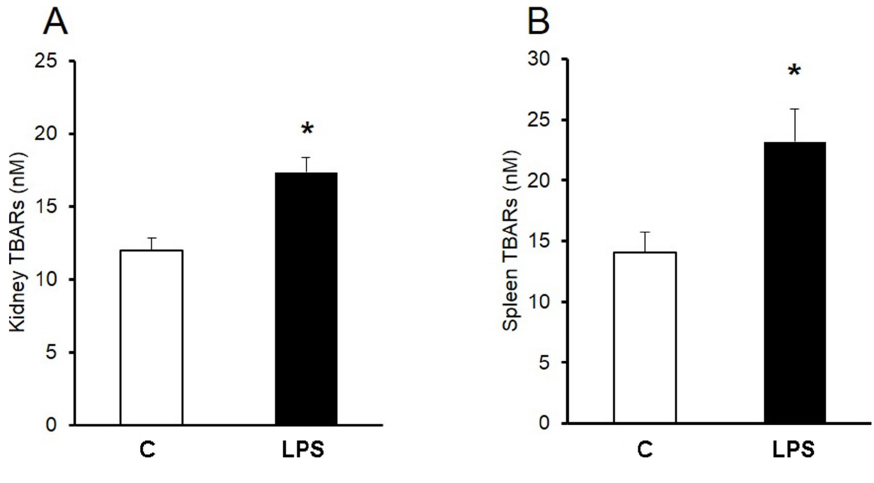
Figure 3. Endotoxemia in mice increases lipid peroxidation in kidney and spleen. Lipid peroxidation is shown in (A) kidney and (B) spleen homogenates from mice 1 h after LPS (15 mg/kg) injection. Data show mean ± SEM of 6–8 animals per group. * p < .05.